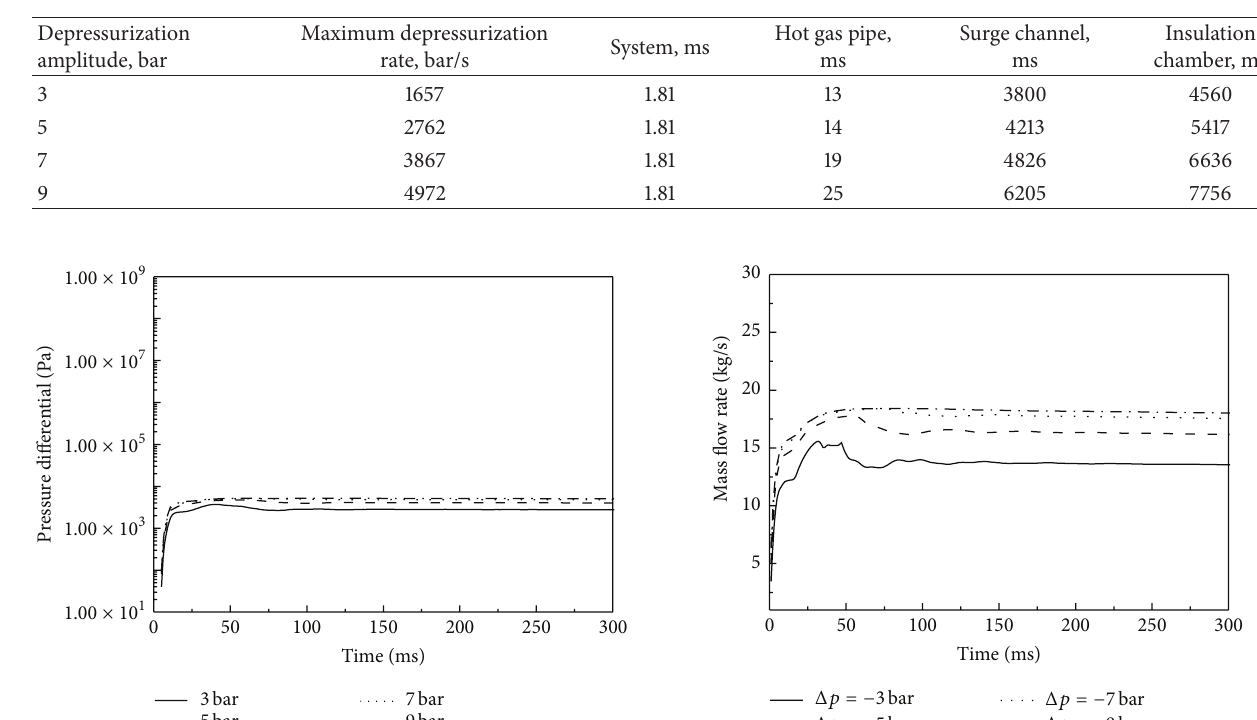
Table 2: Time constant of response for the three zones.